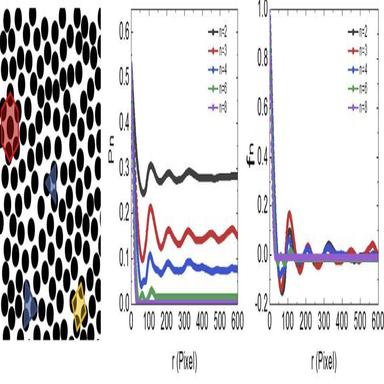
(a) 2D microstructure composed of equal-sized hard spheres in a matrix. (b) The Pn functions for the particle phase with n ¼ 2, 3, 4, 6 and 8. (c) The corresponding rescaled fn functions highlighting the spatial correlations (c.f. Eq..